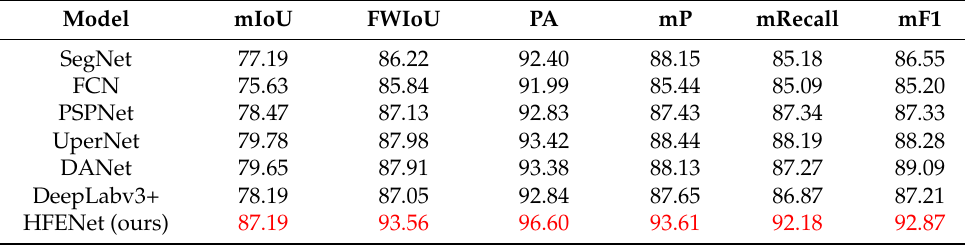
Table 4. The quantitative results of the state-of-the-art models on the MZData (%).